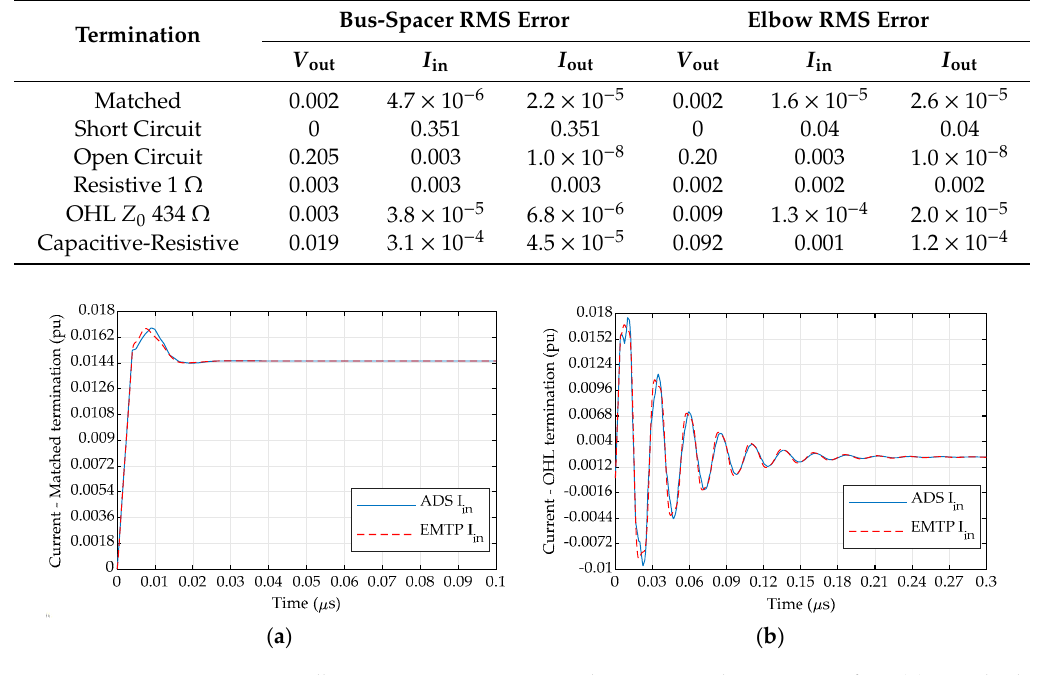
Figure 8. Detailed circuit model.